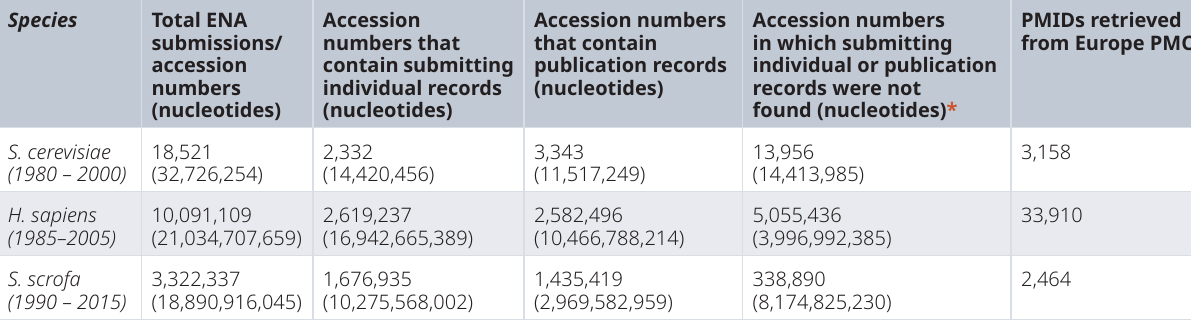
Table 1. Total of ENA accession numbers and Europe PMC publication records retrieved for S. cerevisiae , H. sapiens , and S. scrofa .